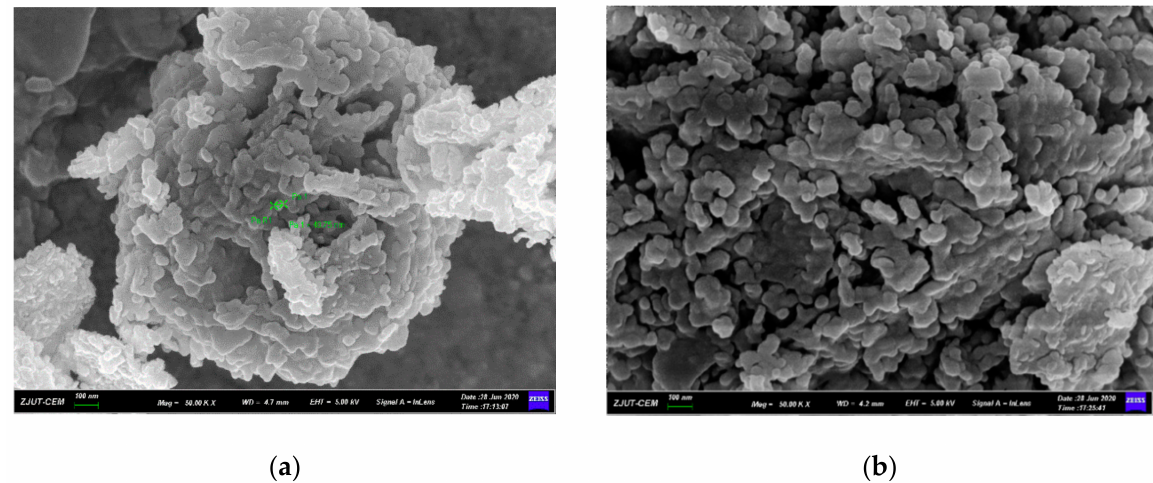
Figure 3. SEM images of nano-MgO. ( a ) with dimensioning and ( b ) without dimensioning. Used F · II type fly ash was purchased from Ningbo Zhenhai Power Plant in Ningbo, China. Its chemical composition and XRD pattern are displayed in Table 1 and Figure 4, respectively. The XRD pattern revealed that mullite and quartz exhibited very sharp diffraction peaks, while the diffraction peaks of other crystalline substances were fainter. Chinese ISO standard sand and tap water were used for all the